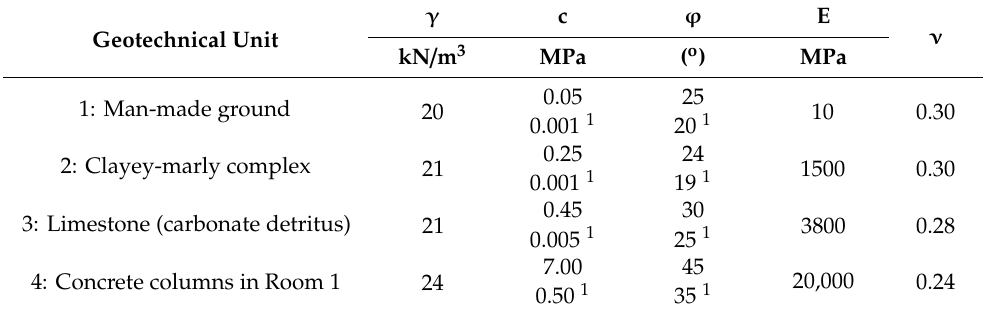
Table 2. Material parameters of geological units and concrete, which were used in the stability